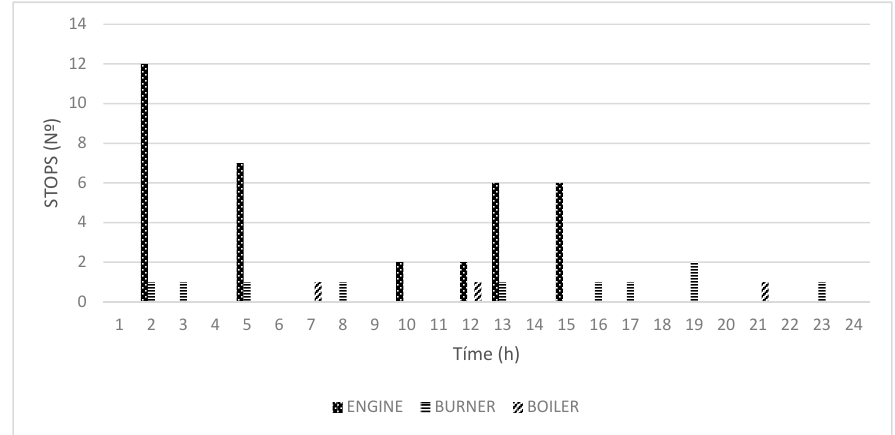
Figure 12. Base engine, burner, and boiler ON/OFF.